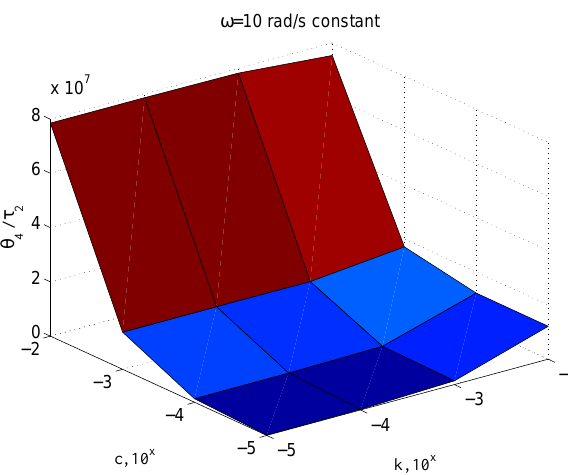
Figure 14. Dependency of ϑ 4 / τ 2 with respect to c and k for an assigned value of ω .